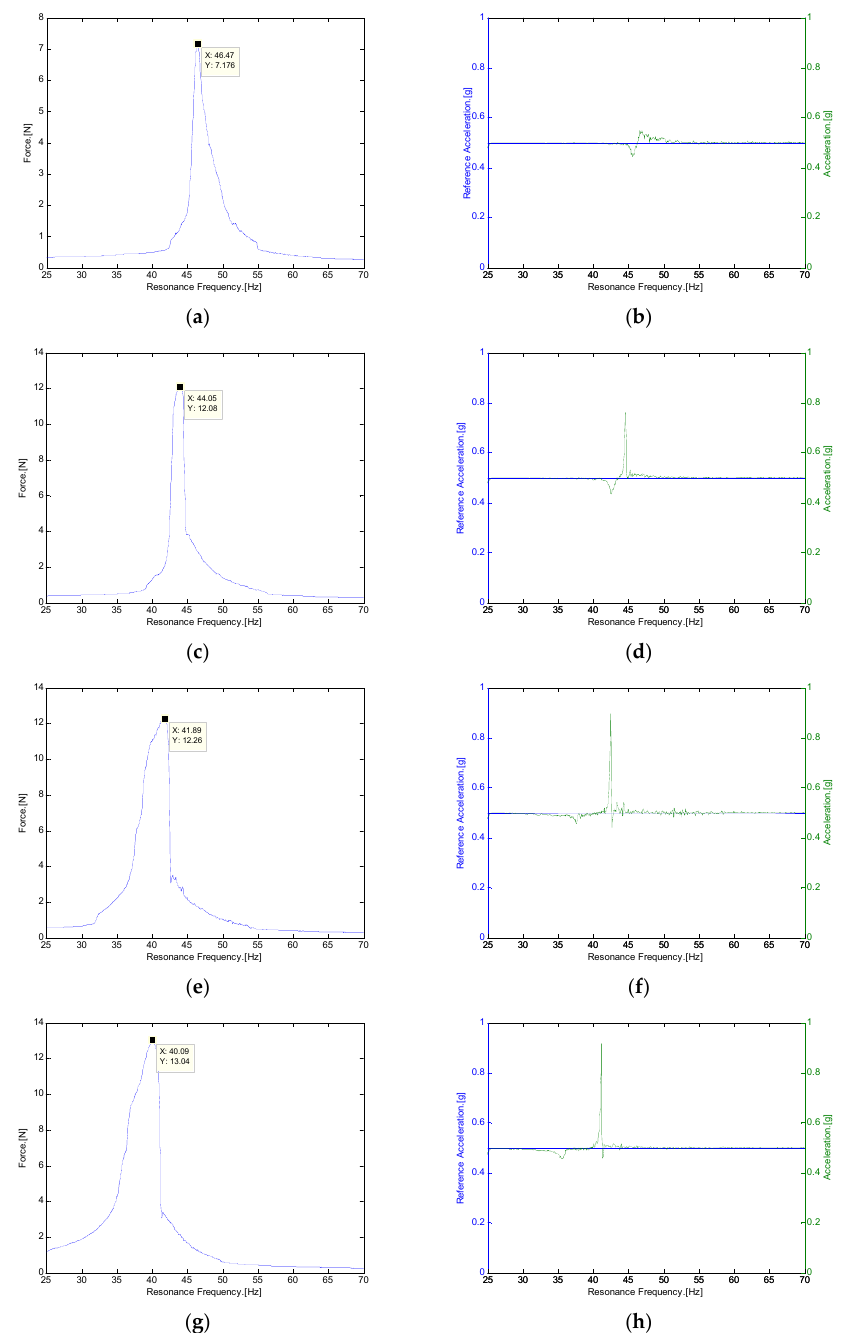
Figure 7. Maximum force and resonance frequency results according to changes in the weight of the mass body. ( Left side ) ( a ) Test 1: the maximum force was 7.176 N at a resonance frequency of 46.47 Hz with an input vibration acceleration of 0.5 G, where the weight of the mass body was 249.7 g (zoomed in); ( c ) Test 2: the maximum force was 12.08 N at a resonance frequency of 44.05 Hz with an input vibration acceleration of 0.5 G, where the weight of the mass body was 299.2 g; ( e ) Test 3: the maximum force was 12.26 N at a resonance frequency of 41.89 Hz with an input vibration acceleration of 0.5 G, where the weight of the mass body was 348.7 g; ( g ) Test 4: the maximum force was 13.04 N at a resonance frequency of 40.09 Hz with an input vibration acceleration of 0.5 G, where the weight of the mass body was 398.2 g; ( Right side ) ( b , d , f , h ) external vibration acceleration of 0.5 G (blue, reference) and the measured acceleration of the magnetic repulsive force tester (green) at the resonance frequency (zoomed